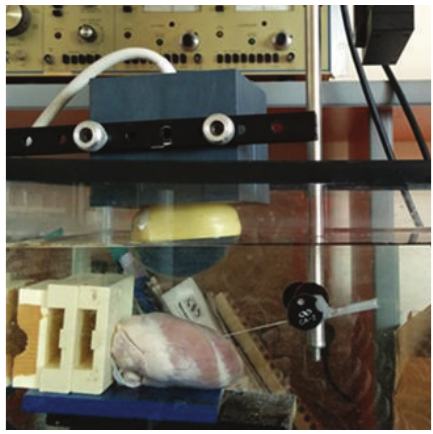
Figure 4: The experimental setting of the real data